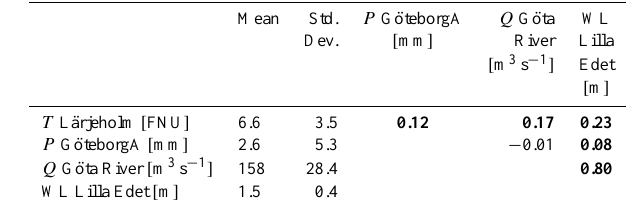
Table 2. Mean, standard deviation, and correlation for annual data Table 3. Mean, standard deviation, and correlation for daily mean at L¨arjeholm (2002–2007), and for the variables turbidity ( T ), pre- data at L¨arjeholm (2002–2007), and for the variables turbidity ( T ), cipitation ( P ), flow ( Q ) and water level (WL). Correlation in bold precipitation ( P ), flow ( Q ) and water level (WL). Correlation in is significant at p < 0.05. bold is significant at p < Mean Std.